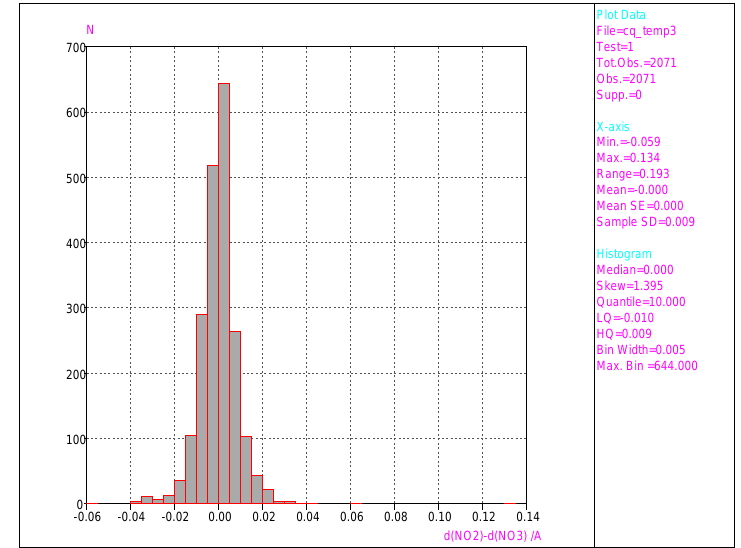
Figure 2. Distribution of differences d (N1O2)- d (N1O3) for para -substituted nitrobenzene derivatives (labeling of atoms in Scheme 1).